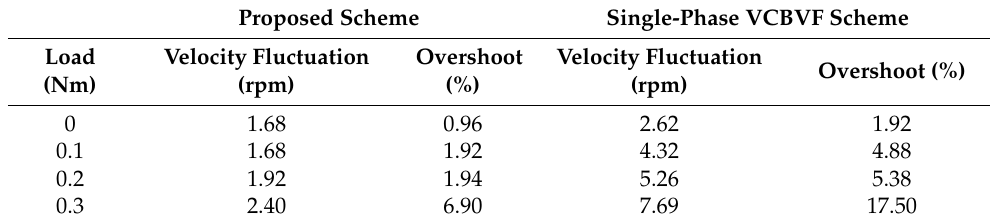
Table 2. Control performance of the TRUSM.